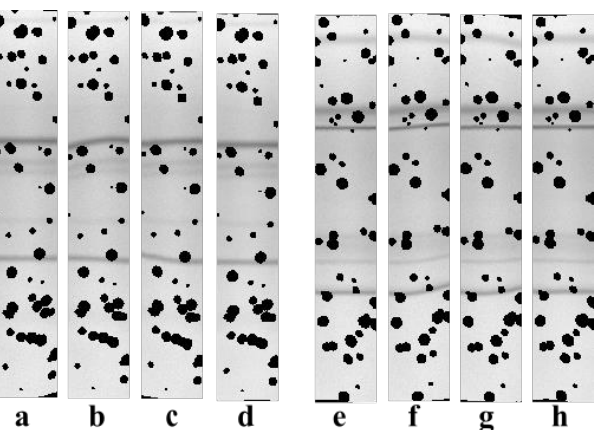
Figure 8. Illustration of band straightening on two synthetic profiles: ( a , e ): non-deformed synthetic lanes; ( b , f ): digitally added non-uniform band deformations; ( c , g ): results of band straightening with OCBSA-2016; ( d , h ): results of band straightening with OCBSA-2021.